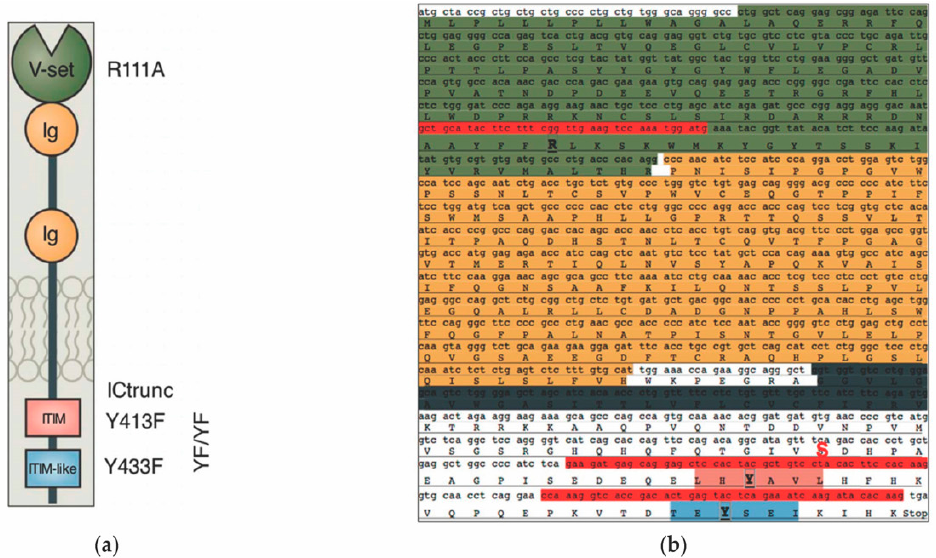
Figure 1. ( a ) A graphical representation of Siglec-6 representing the structural components of the proteins including the v-set sialic-acid binding domain (green), two extracellular immunoglobulins (Ig) domains (gold), the transmembrane domain (grey), and the intracellular ITIM (pink) and ITIM- like (blue) putative signaling motifs (adapted from [9]). ( b ) SIGLEC6 gene sequence with primers used for mutagenesis (highlighted in red) and specific site-directed mutations that were created in the structural domains (highlighted in bold): Alanine to arginine mutation in the v-set domain (R111A), Tyrosine to phenylalanine mutations in the membrane-proximal ITIM (Y413F), distal ITIM-like (Y433F), and both (YFYF). A serine1521 to a STOP codon mutation was created to generate an intracellularly truncated version of Siglec-6 (ICTrunc) (highlighted in red and bold).